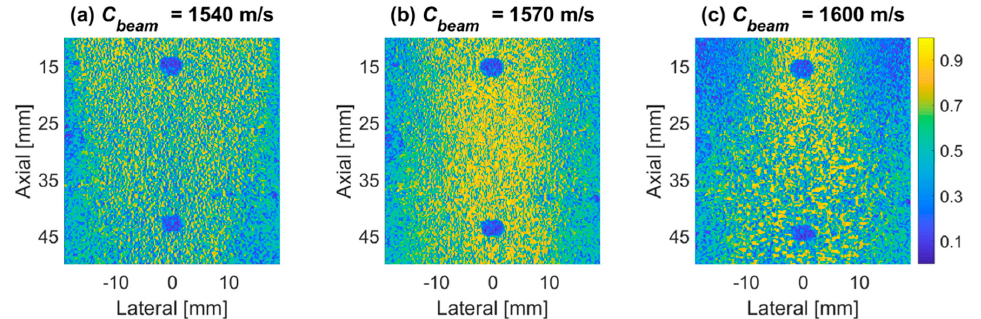
Figure 9. DCF maps of Tx-DMAS beamforming with C beam of 1540, 1570 and 1600 m/s of PICMUS experimental phantom.